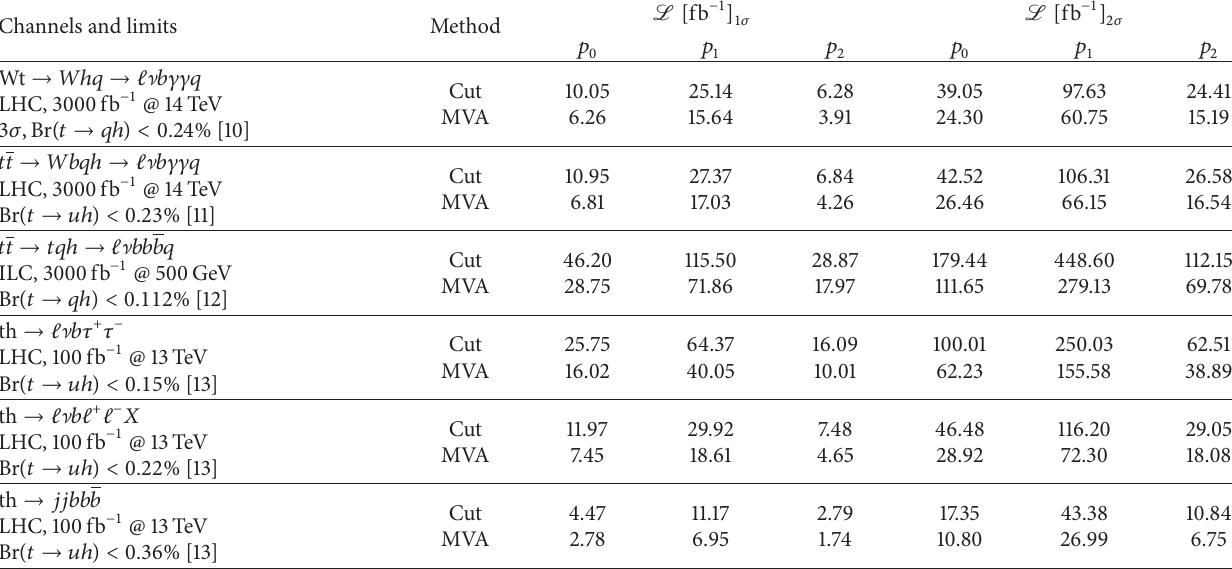
Table 5: The same as Table 4 but for some other phenomenological studies. Channels and